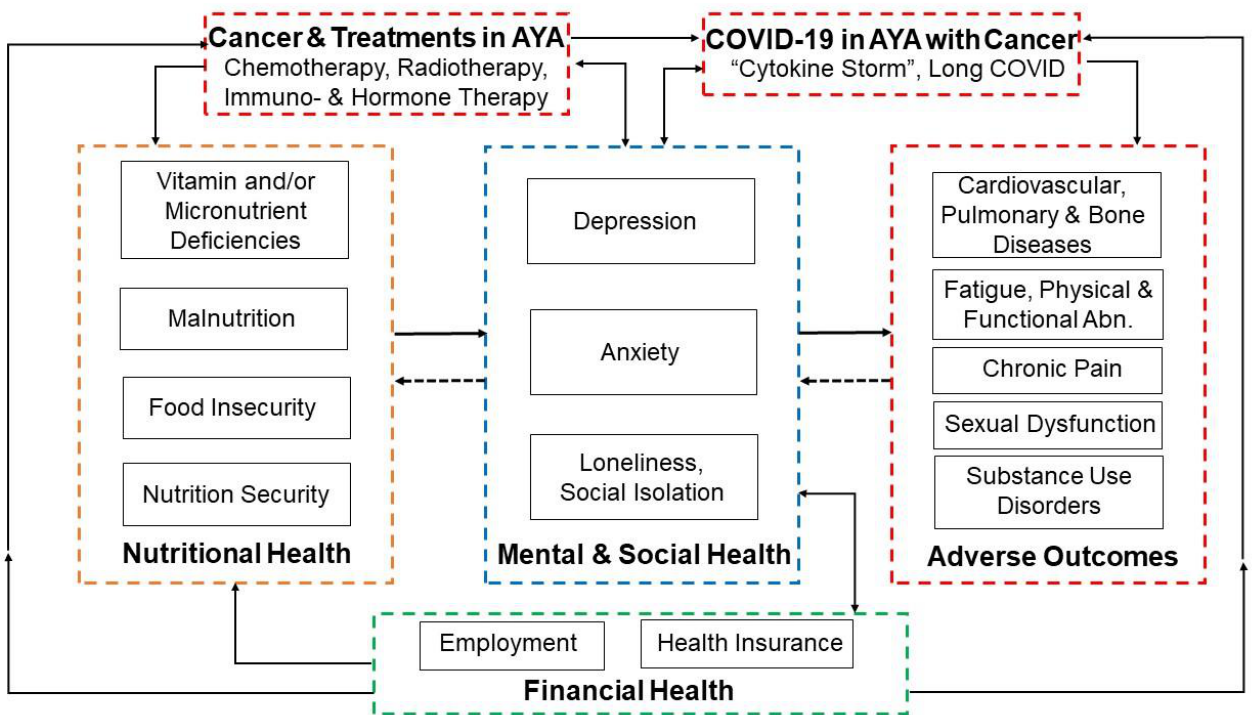
Figure 1. Food and Nutrition Insecurity in Adolescent and Young Adult (AYA) Cancer Survivors: Treatments for cancer may exacerbate nutritional deficiencies and adverse health outcomes (“late effects”) in AYA cancer survivors. Higher levels of financial insecurity and mental health issues common in this population as well as the COVID-19 pandemic may exacerbate effects of food and nutrition insecurity.